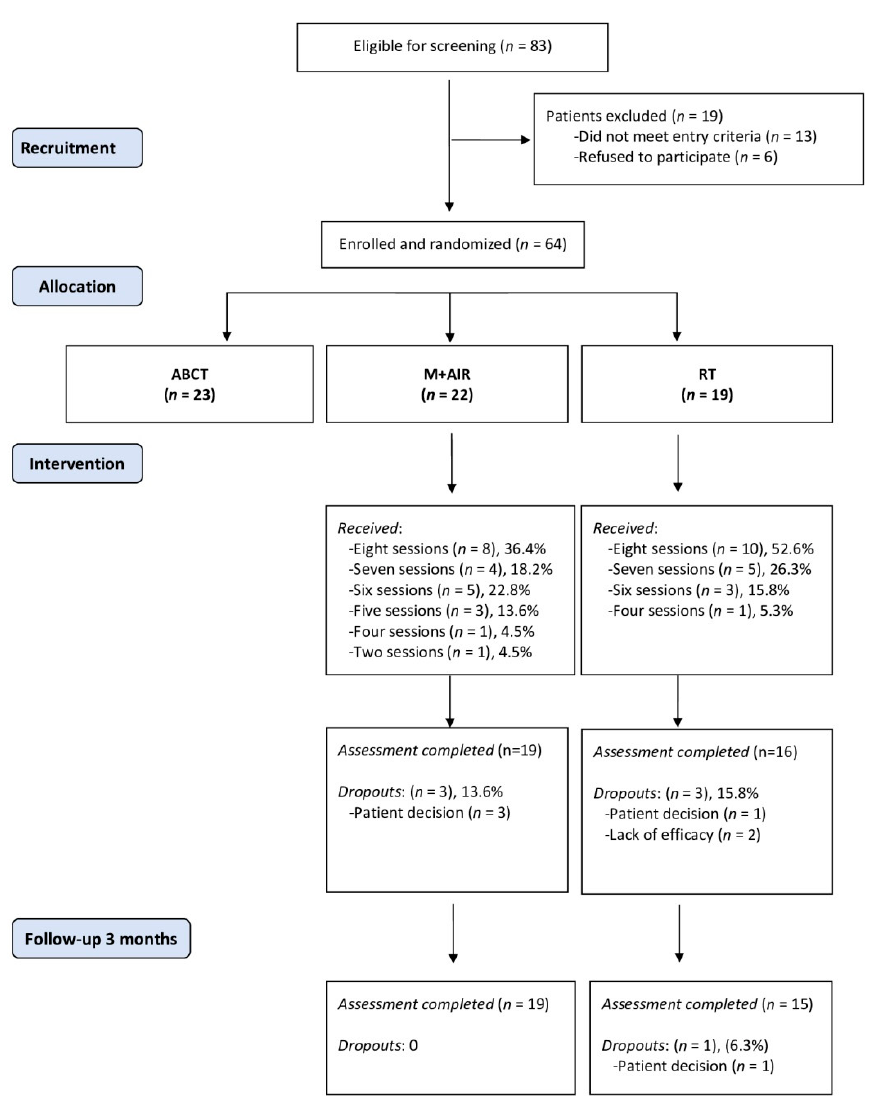
Figure 1. Flowchart of participants in the pilot Randomized Controlled Trial (RCT). Note: The results of the ABCT arm were detailed in Montero-Mar í n et al. (2018) [30]. ABCT: attachment-based compassion therapy; MAIR: mindfulness plus amygdala and insula retraining; RT: Relaxation Therapy. More details regarding the ABCT arm can be found in Montero-Marin et al.